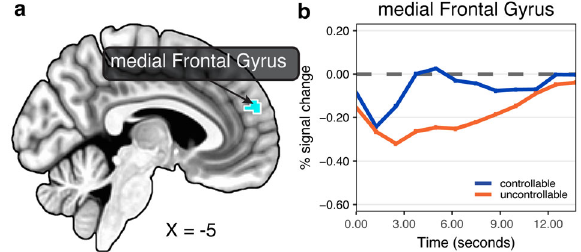
Fig. 8 Exploratory voxelwise analysis. a Voxelwise threshold at 0.005 and cluster extent of at least 10 voxels: controlled > uncontrolled. b Estimated response of the medial frontal gyrus cluster based on unassumed shape analysis (% signal